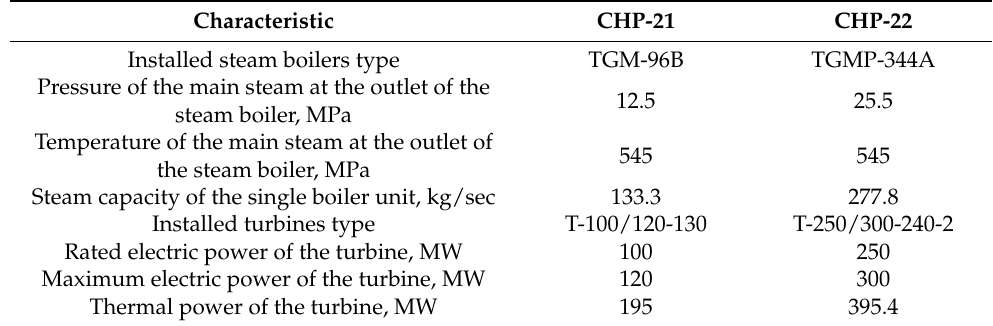
Table 5. Characteristics of the equipment installed at CHP-21 and CHP-22 (St. Petersburg). Characteristic CHP-21 CHP-22 Installed steam boilers type TGM-96B TGMP-344A Pressure of the main steam at the outlet of the 12.5 25.5 steam boiler, MPa 545 545 the steam boiler, MPa 133.3 277.8 Installed turbines type T-100/120-130 T-250/300-240-2